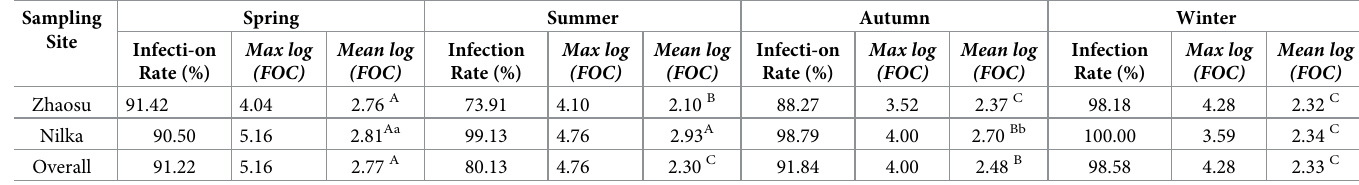
Table 4. Sheep coccidia infection rate (%) and Log (FOC) of different regions for various seasons. Sampling Spring Summer Autumn Winter Site Infecti-on Rate